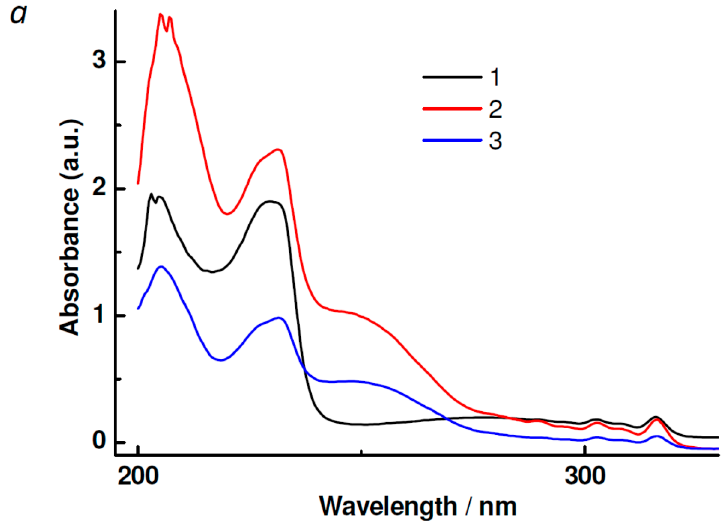
Figure 5. Cont . Figure 5. Cont .